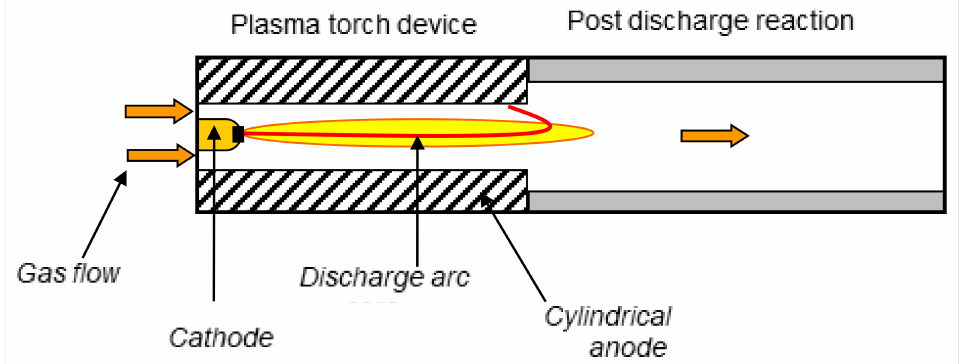
Figure 1. Scheme of a low-current plasma